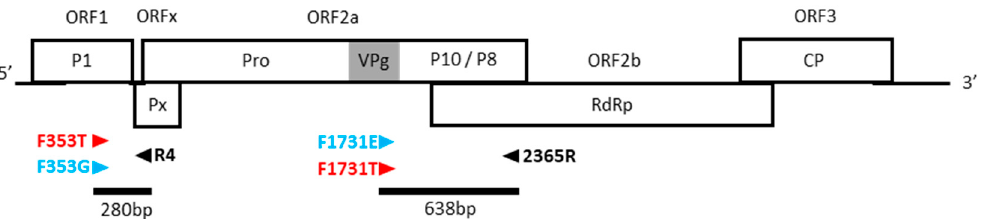
Figure 2. Positions of primers on RYMV genomic organization. Open reading frames (ORFs) and the proteins they encoded are indicated. Protein P1, protein X (Px), proteinase (Pro), VPg (in grey), putative P10/P8, RNA-dependent RNA-polymerase (RdRp), and coat protein (CP). Primer positions and PCR products are indicated by triangles and solid lines, respectively.